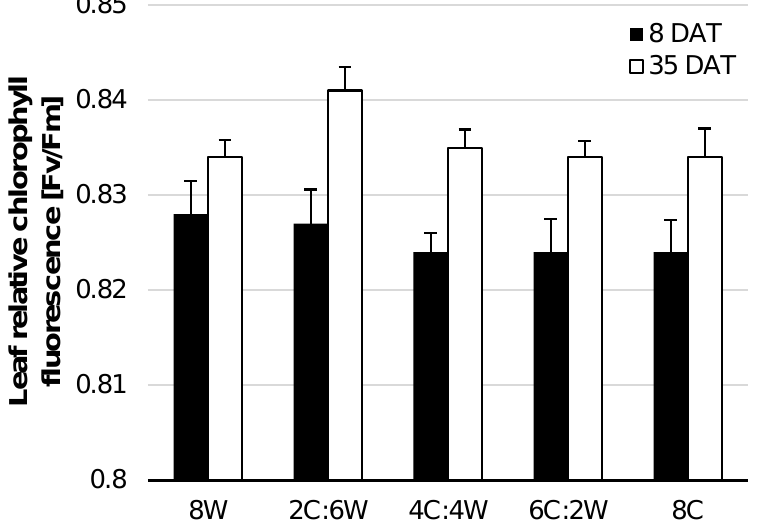
Figure 7. Leaf relative chlorophyll fluorescence (Fv/Fm), 8, 16, 28 and 35 DAT. Vertical bars denote standard errors of means. WF L remained unaffected by substrate ratios of 8W (283.85 ± 17.27 g), 2C:6W (283.97 ± 10.11 g), 4C:4W (287.1 ± 9.13 g), 6C:2W (303.52 ± 11.25 g) and 8C (286.11 ± 6.50 g),